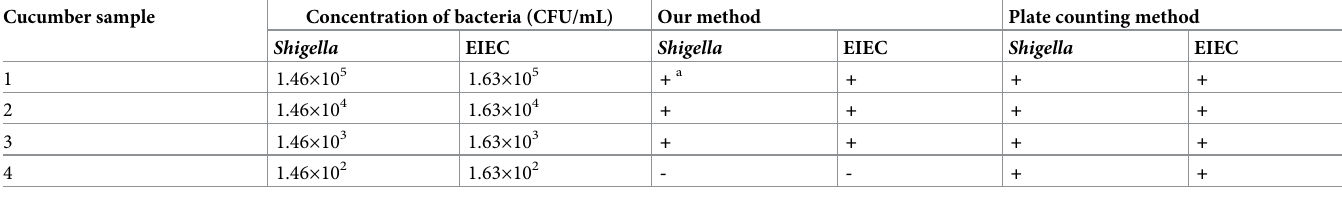
a The symbol "+" indicates that the method can detect bacteria; the symbol "-" indicates that the method cannot detect